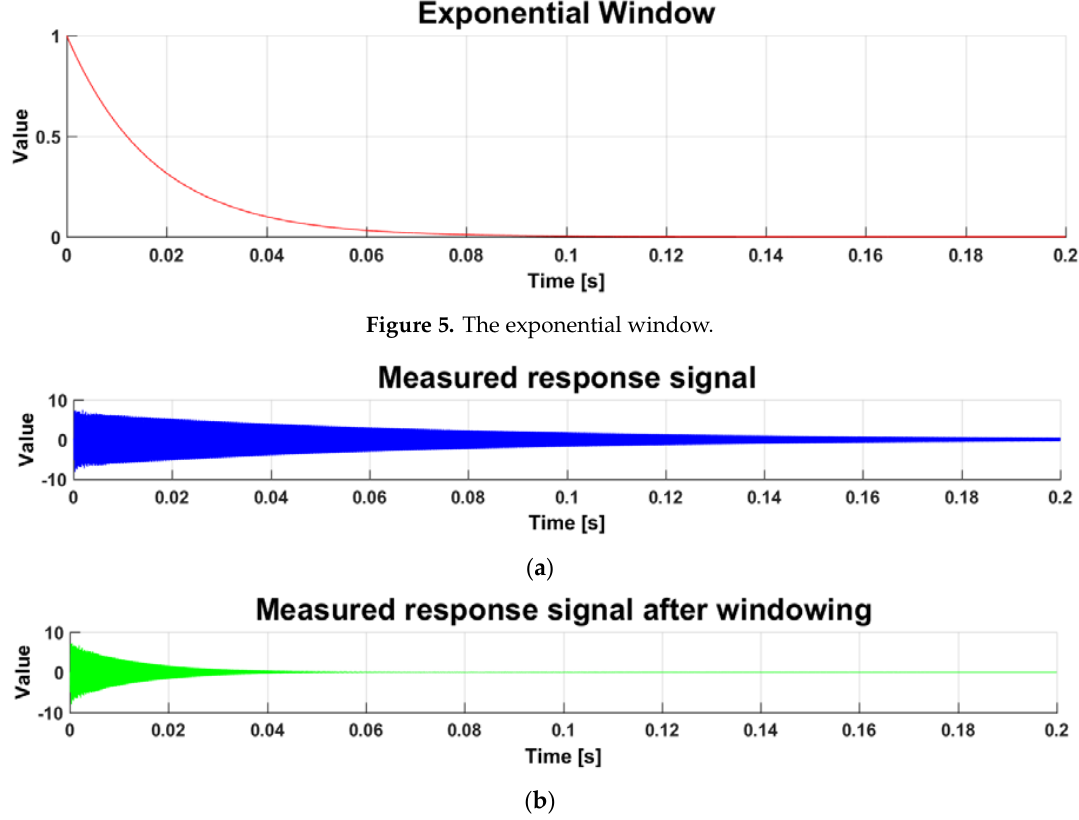
Figure 6. Measured response signal of a lightly damped blade system for impact excitation and its modification by the exponential window.